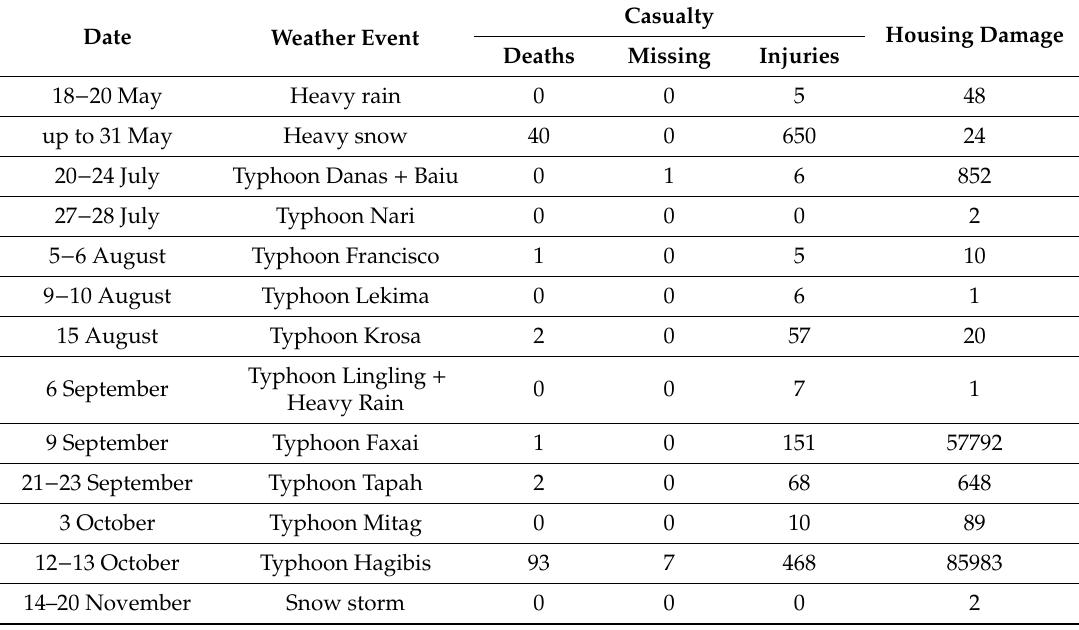
Table 1. Summary of 2019 Weather Disasters in Japan